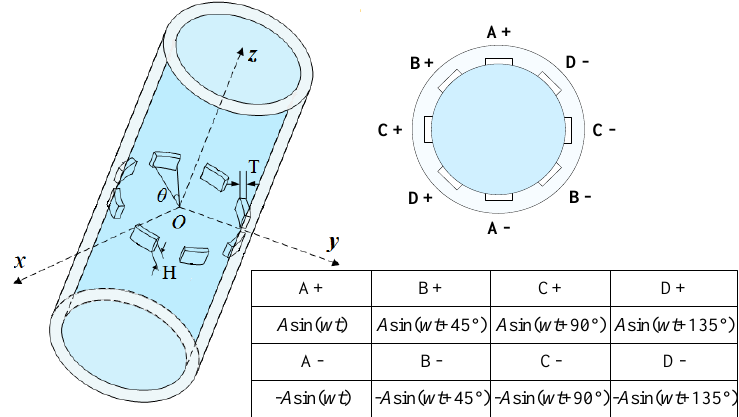
Figure 4. Geometric structure and parameters of the rotating electric field conductance sensor